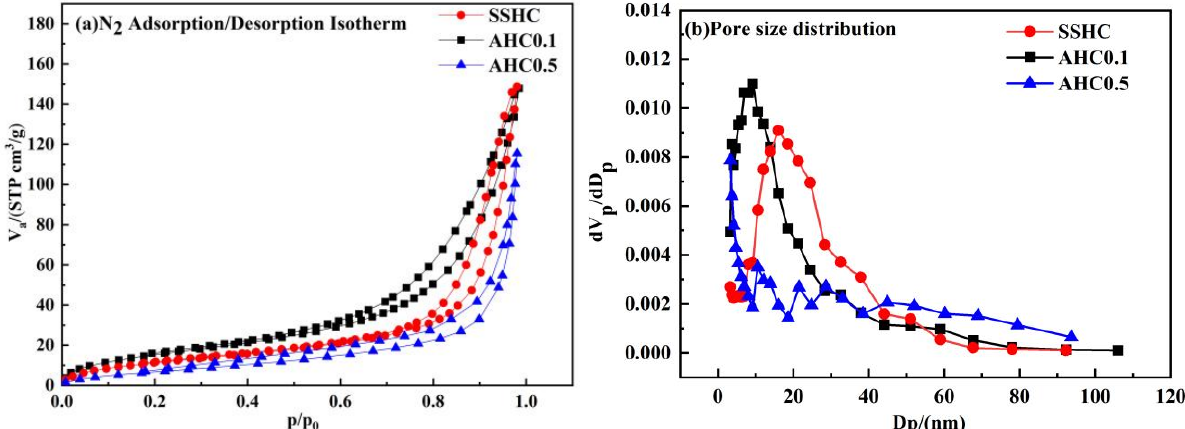
Figure 4. N 2 adsorption/desorption isotherm plots ( a ) and pore size distribution curves ( b ). Table 4. Pore characteristics of SS-derived hydrochars.